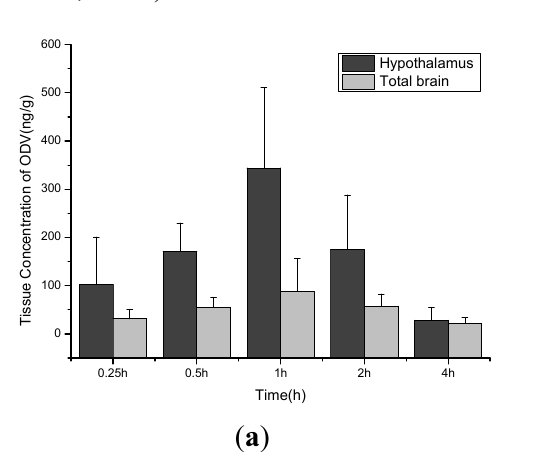
Figure 3. Concentrations of ODV in the hypothalamus and total brain produced after single oral doses of ( a ) ODV, ( b ) compound 1c , ( c ) compound 1e , ( d ) compound 1n and ( e ) compound 1o . ( f ) shows the concentrations of ODV in the hypothalamus after administration of ODV, 1c , 1e , 1n and 1o to rats at a dose of 0.06 mmol/kg (data are means + SD, n =